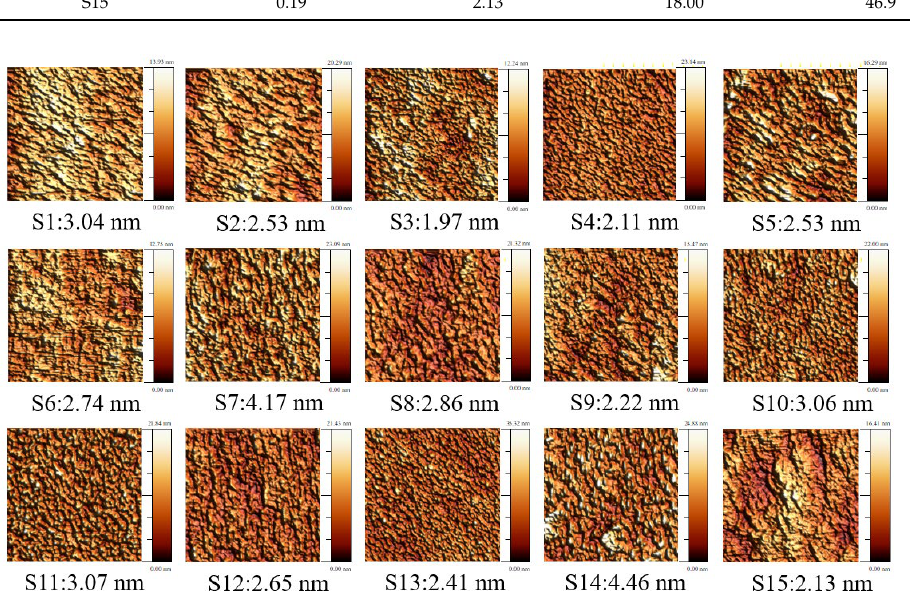
Figure 6. AFM images of AlN films (S1–S15 in RMS surface roughness) as deposited on Si (100) substrates.